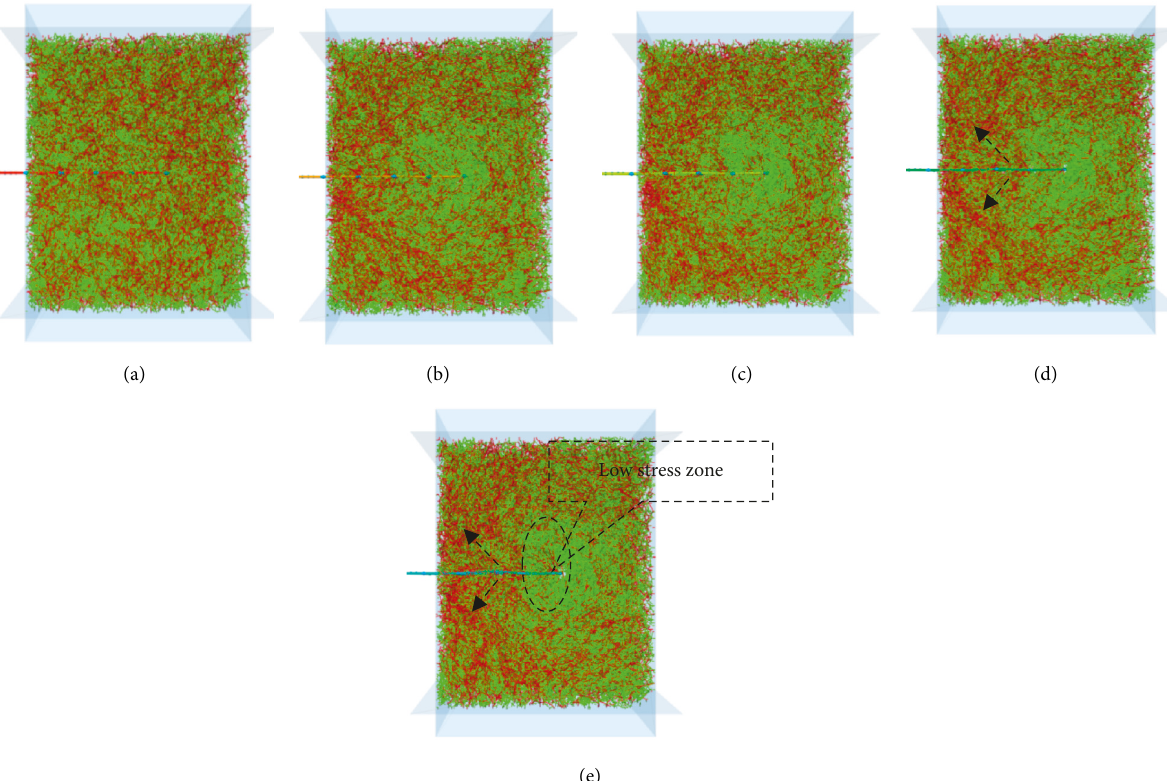
0mm, (b) L 4 mm, (c) L 8mm, (cid:31) (cid:31) (cid:31)